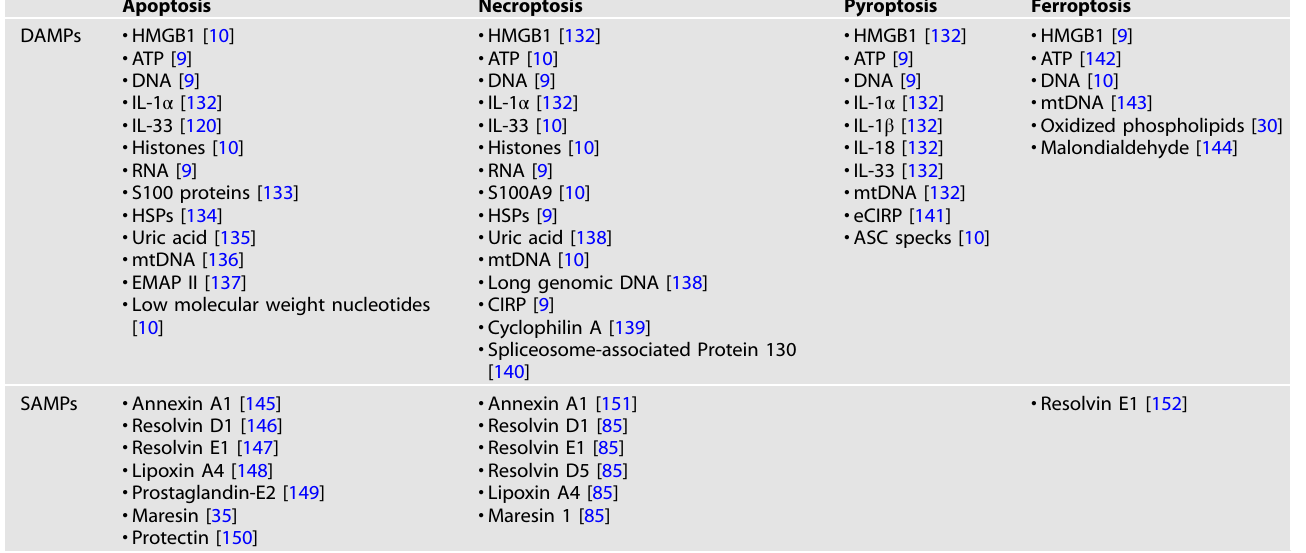
Table 2. DAMPs and SAMPs released in different cell death forms. Apoptosis